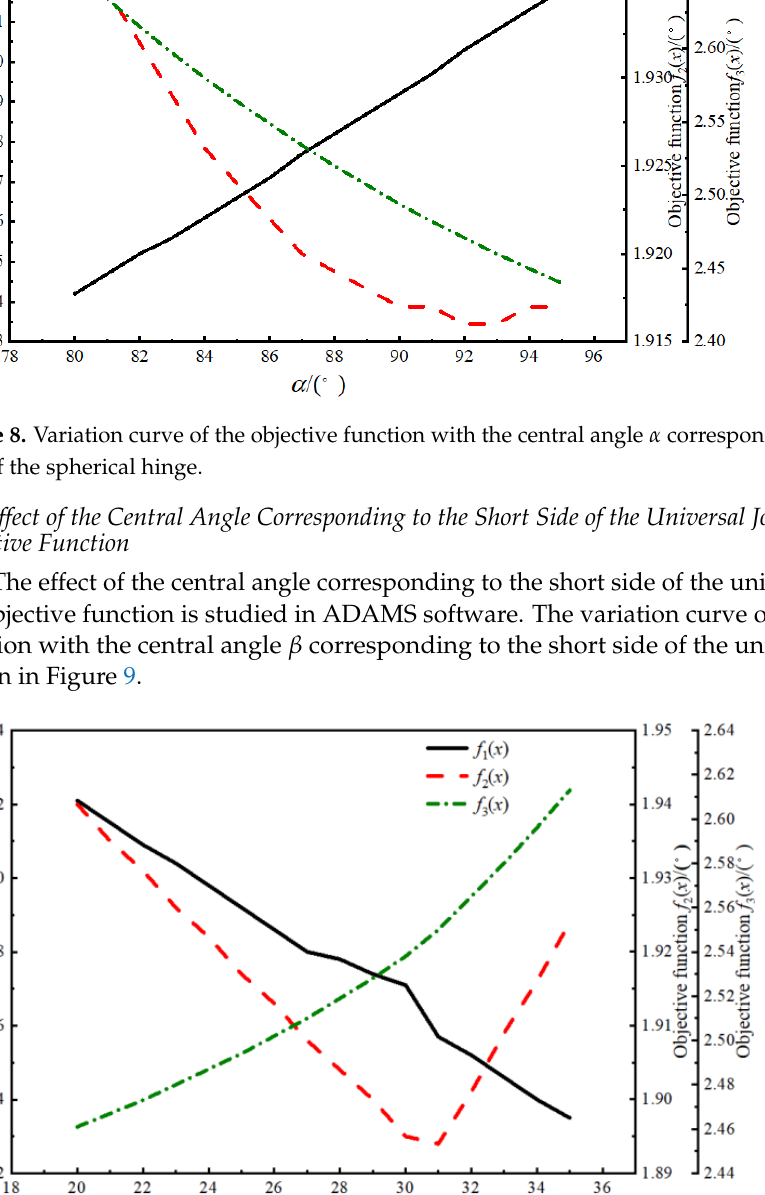
Figure 8. Variation curve of the objective function with the central angle α corresponding to the long side of the spherical hinge.